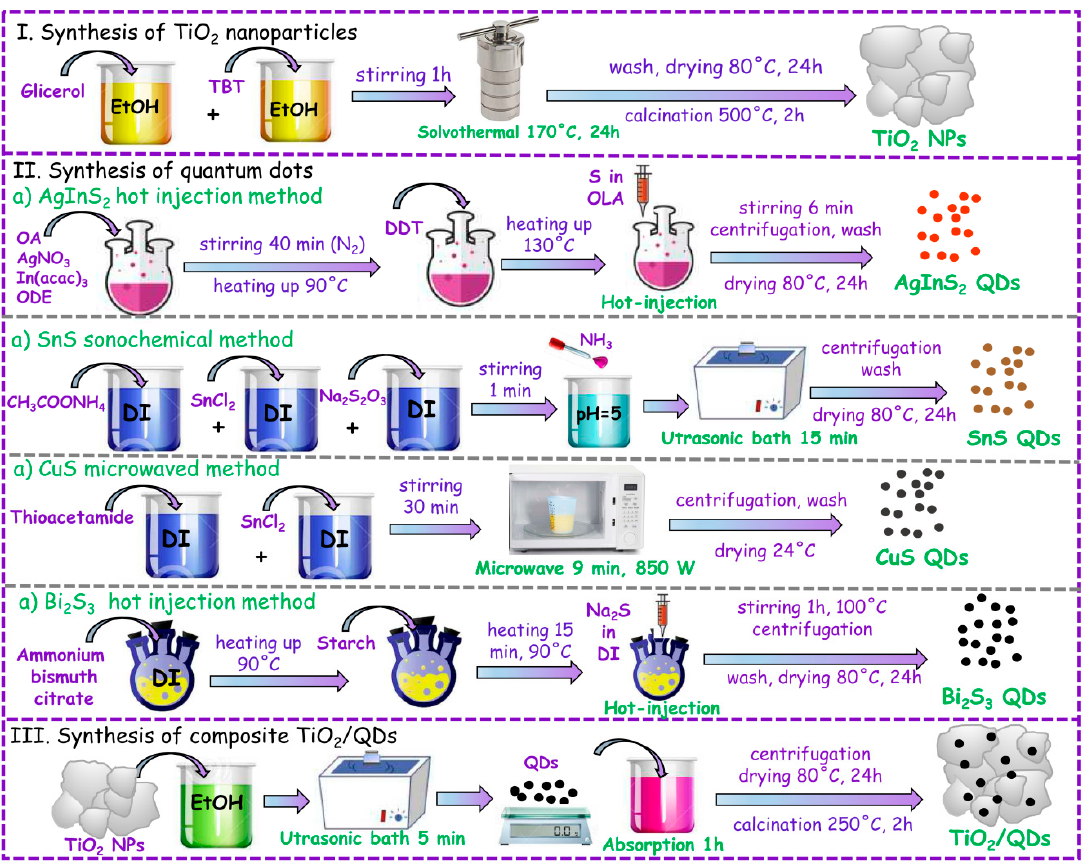
Figure 10. Schematic diagram for the formation of TiO 2 , QDs (AgInS 2 , SnS, CuS, Bi 2 S 3 ) and TiO 2 / QDs